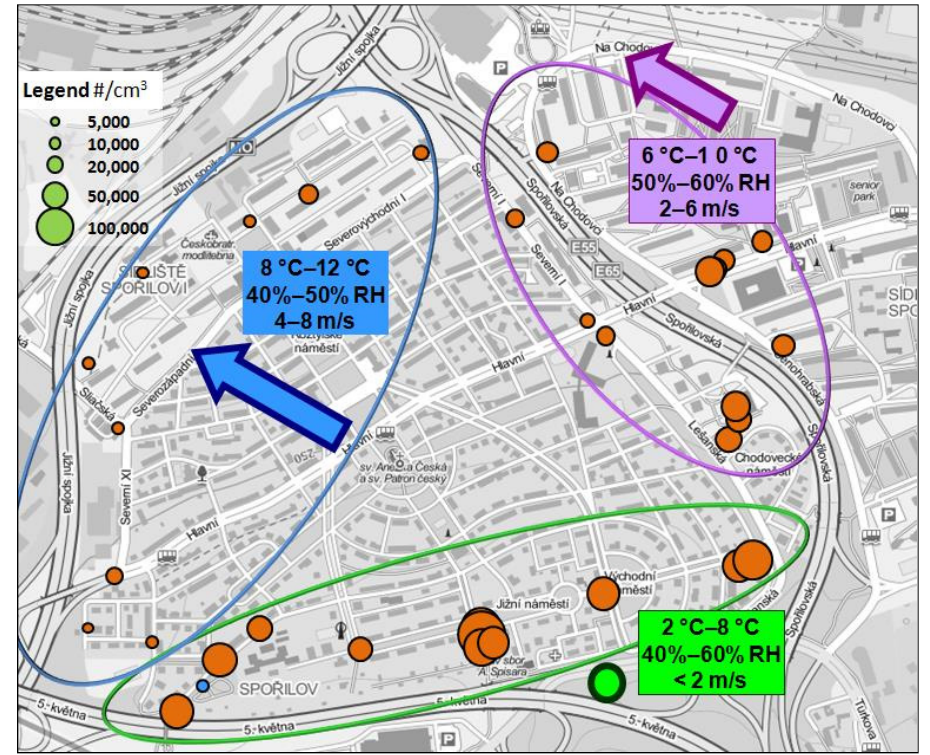
Figure 7. Measured average UFP concentrations within changing meteorological conditions in Sporilov on 12 March; during windless conditions, the highest averaged concentrations were measured in a building estate. Along with increasing wind speed measured particle number concentrations were gradually decreasing. Even within good dispersion conditions the particle number concentrations exceeded Prague background. Dots in a green ellipse represent measurement between 7:20–8:30 a.m.; purple, 8:30–10:00 a.m.; and blue, and 10:00–11:30 a.m.; Map sources: Mapy.cz, Seznam.cz